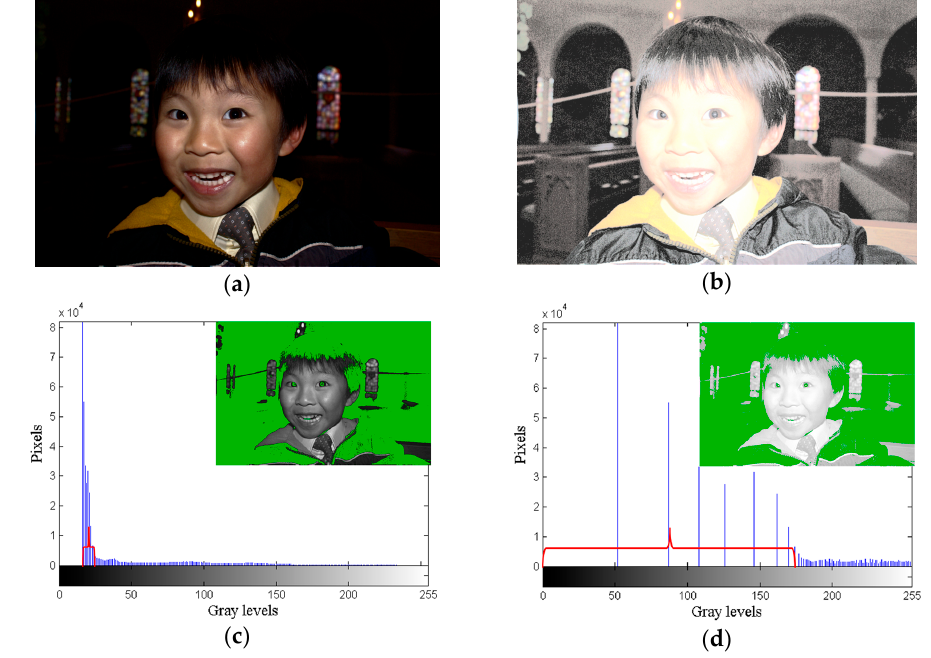
Figure 1. Daniel image (image size: 1935 × 1294 pixels). ( a ) Original image; ( b ) HE image; ( c ) original histogram; ( d ) HE histogram.